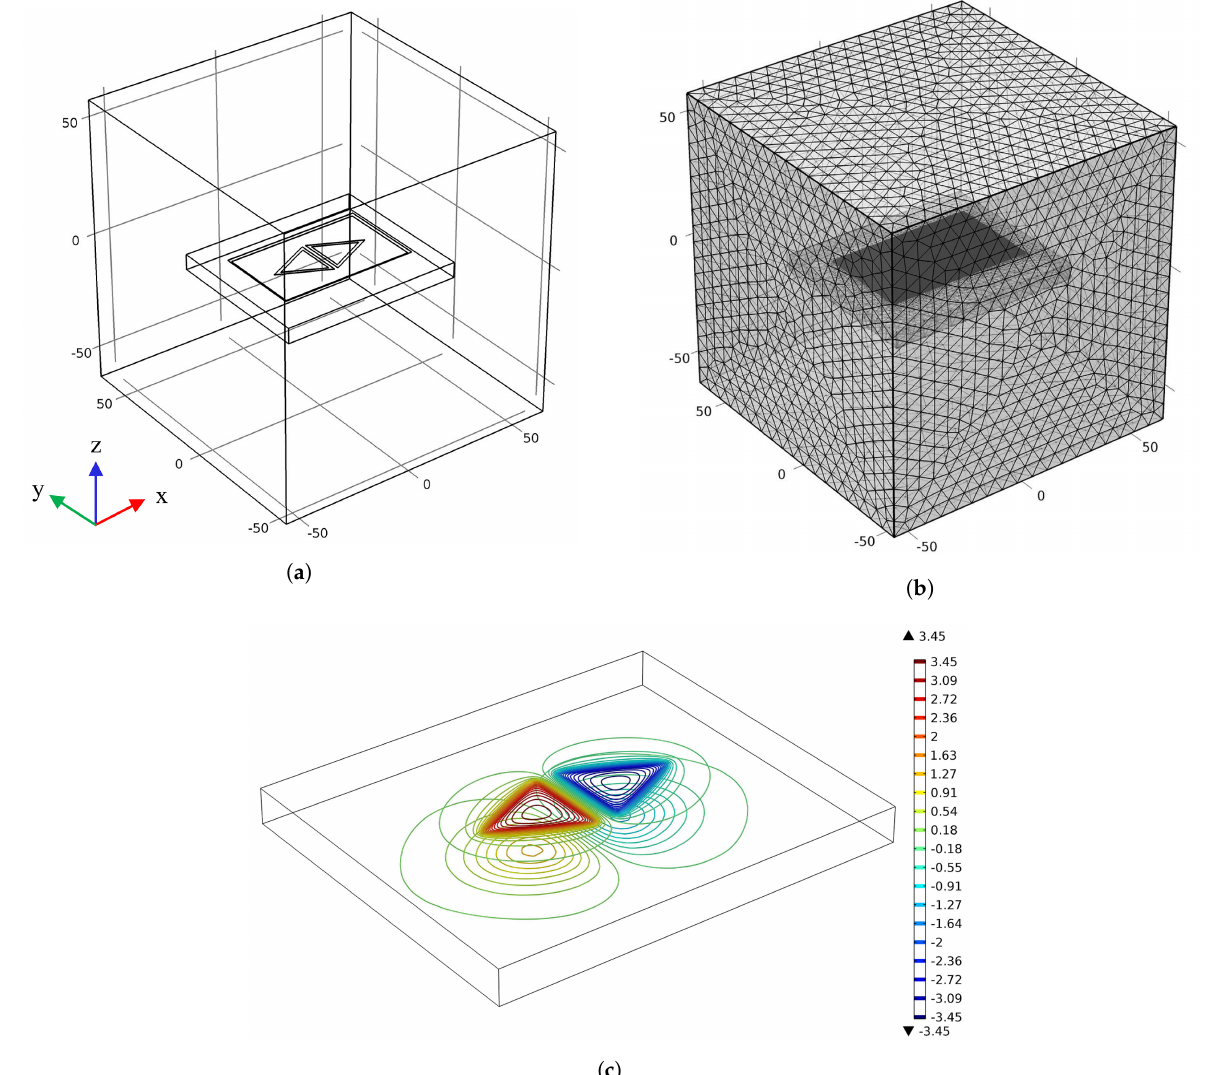
Figure 4. 3D model of the finite element modeling: ( a ) the computational domain (120 mm × 120 mm × 120 mm) with a coplanar capacitive probe, ( b ) model after finite element mesh generation, and ( c ) The electric potential contour lines on the surface of the sound